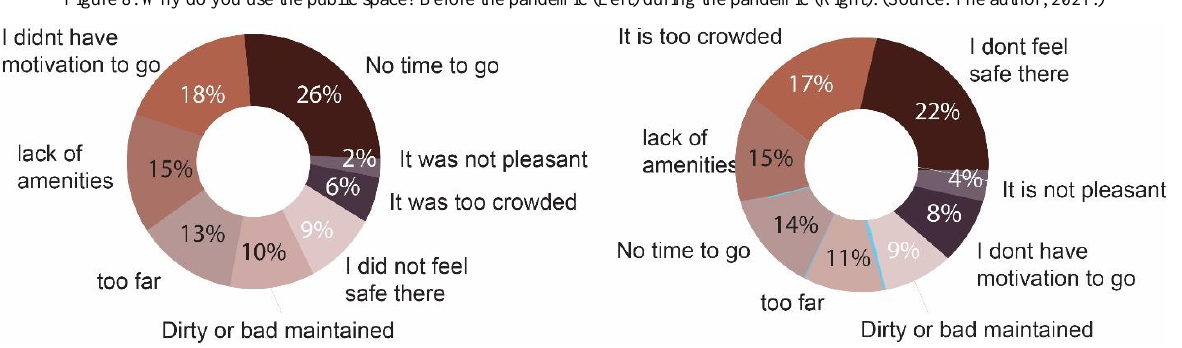
Figure 9: Why don’t you use the public space more often? Before the pandemic (left) during the pandemic (right). (Source: The author,